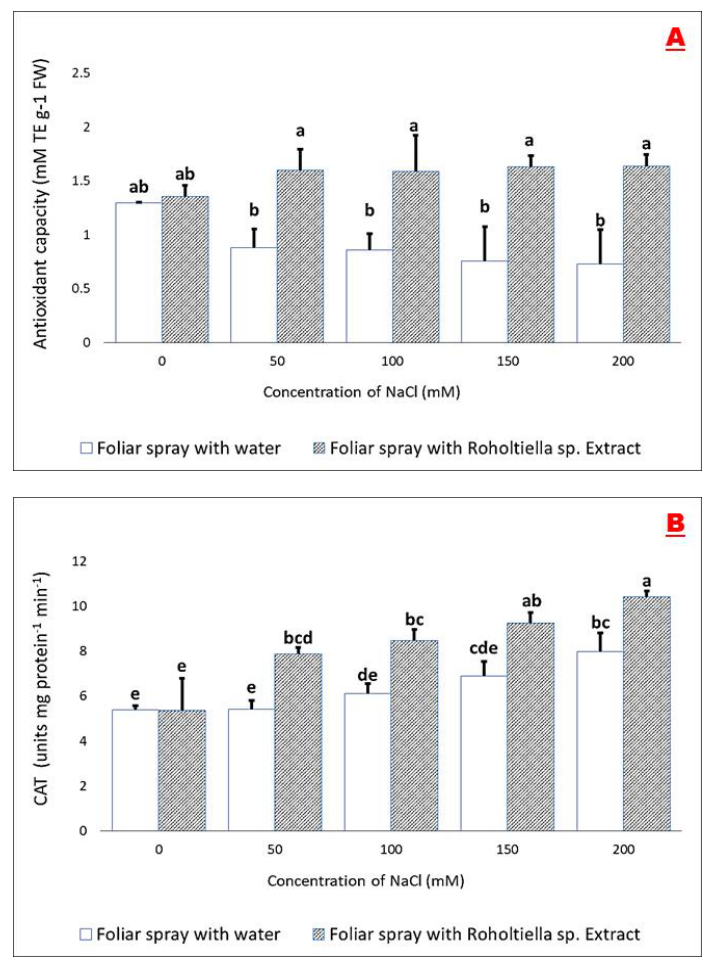
Figure 4. Effect of Roholtiella sp. extract on the Trolox equivalent antioxidant capacity ( A ) and activity of catalase (CAT) ( B ) in induced bell pepper seedlings under salt stress. Bars accompanied with different letters indicate significant differences according to Turkey’s test at a significant level of 5% ( p < 0.05). Salinity concentrations are 0, 50, 100, 150, and 200 mM. The different letters (a–d) indicate significantly different values in response to the different